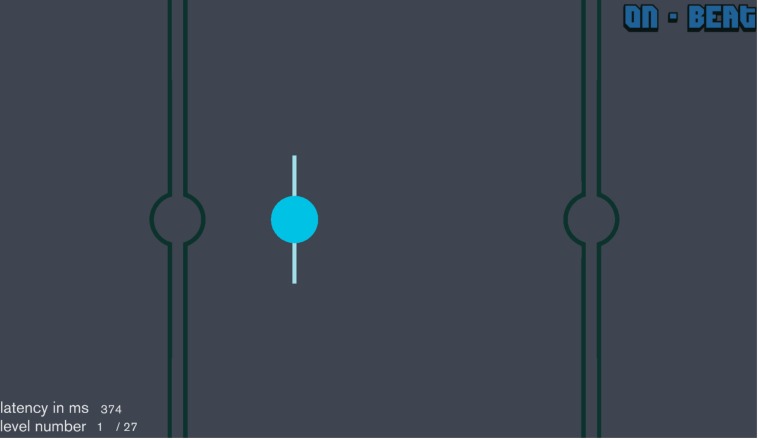
Screenshot of experimental paradigm.